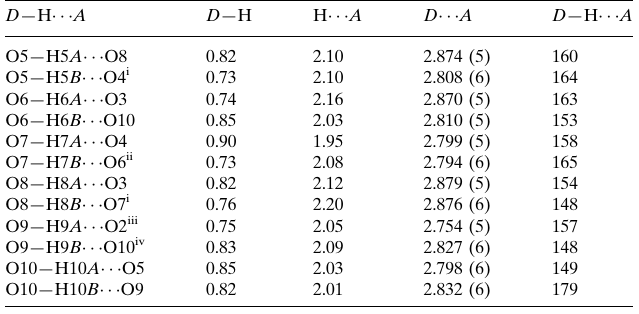
Hydrogen-bond geometry (A˚ , (cid:2)